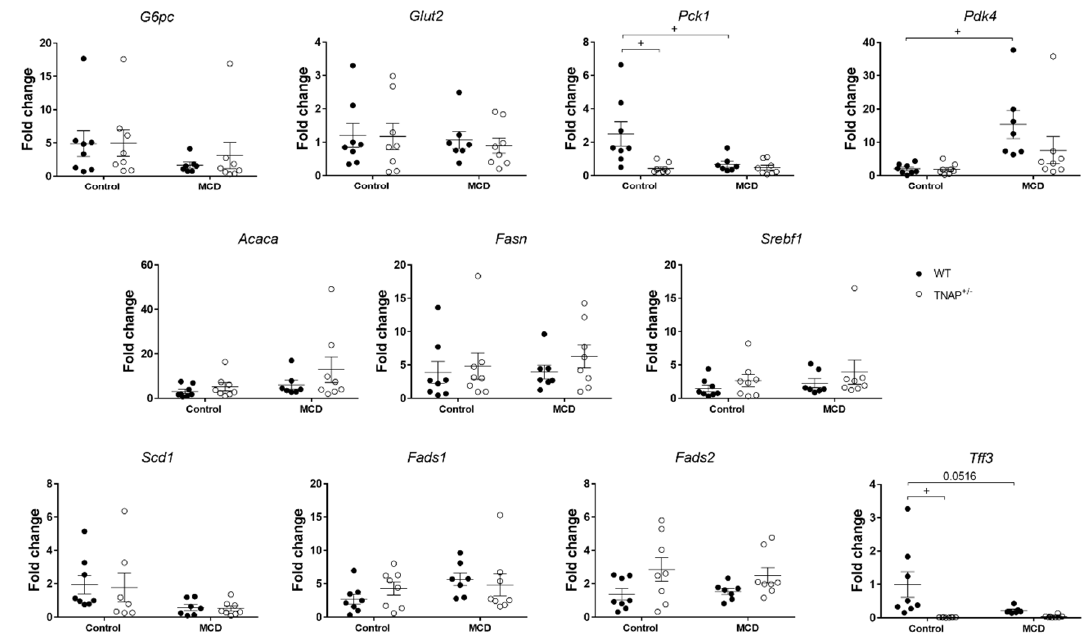
Figure 4. Hepatic expression of glucidic and lipidic metabolism genes in wild-type (WT) and TNAP heterozygous mice (TNAP +/ − ) fed a control diet (10% w/w fat, control) or the same diet deficient in choline and methionine (MCD). Fold change of qRT-PCR data are shown. + p < 0.05.